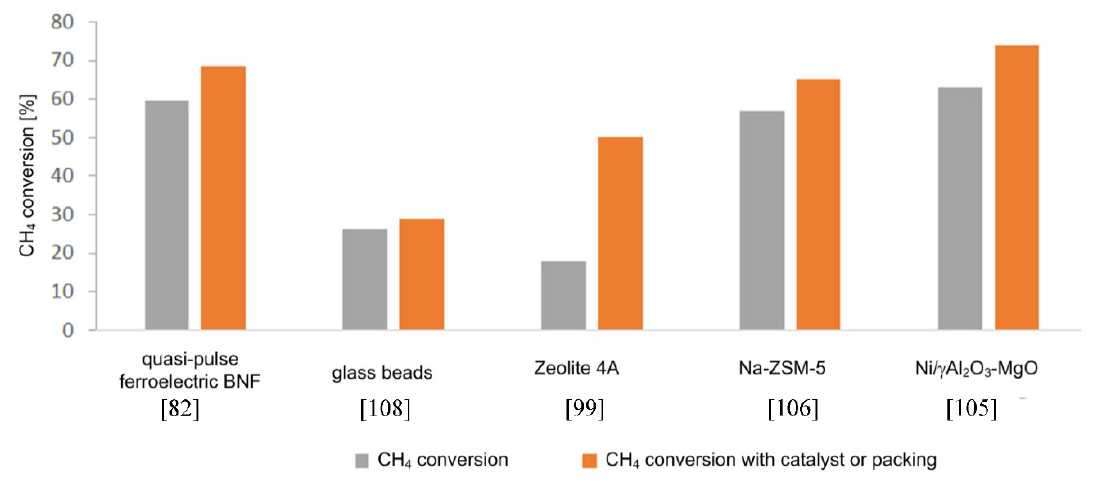
Figure 7. Influence of the packing material on CH 4 conversion.